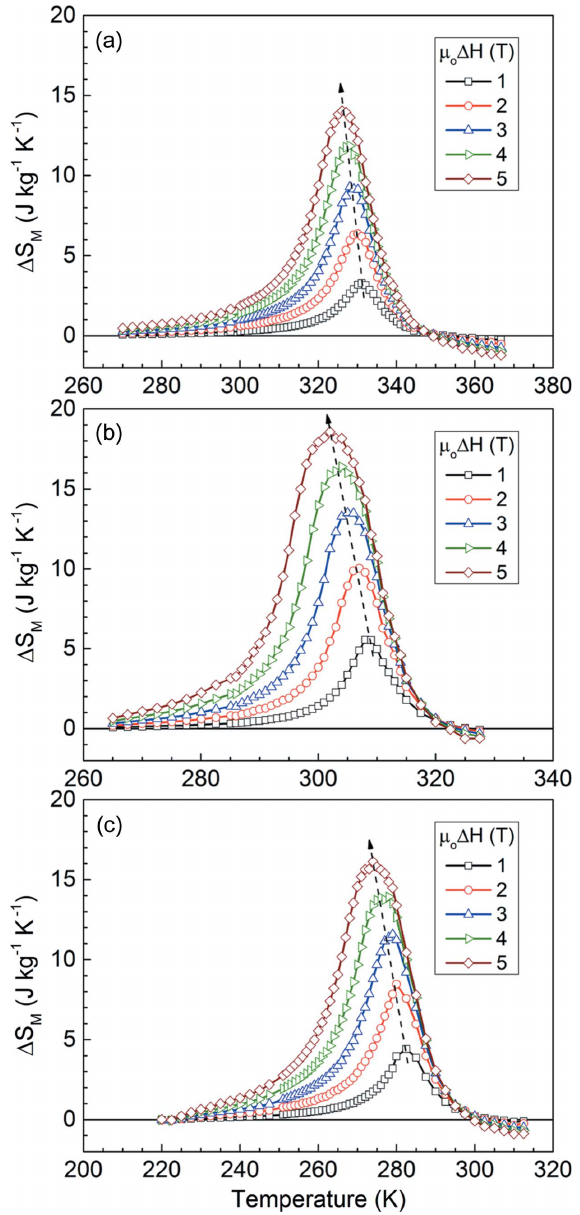
Figure 10 Magnetic entropy change (cid:2) S M as a function of temperature through the inverse martensitic transformation for magnetic field changes ranging from 1 to 5 T for ( a ) Mn 50 Ni 36 Co 6 Sn 8 , ( b ) Mn 50 Ni 35 Co 7 Sn 8 and ( c ) Mn 50 Ni 34 Co 8 Sn 8 ribbon